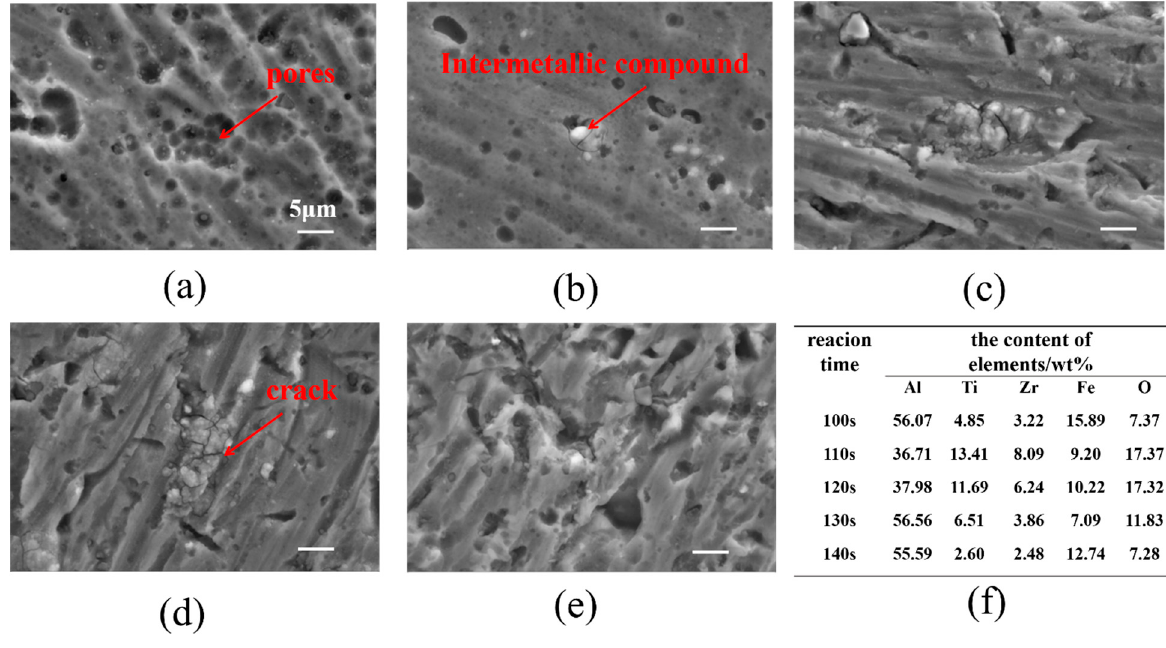
Figure 4. Results of SEM and EDS of 6061 aluminum alloy with synchronous chemical conversion at different times: ( a ) at 100 s, ( b ) at 110 s, ( c ) at 120 s, ( d ) at 130 s, ( e ) at 140 s, ( f ) the EDS result of the conversion coating.